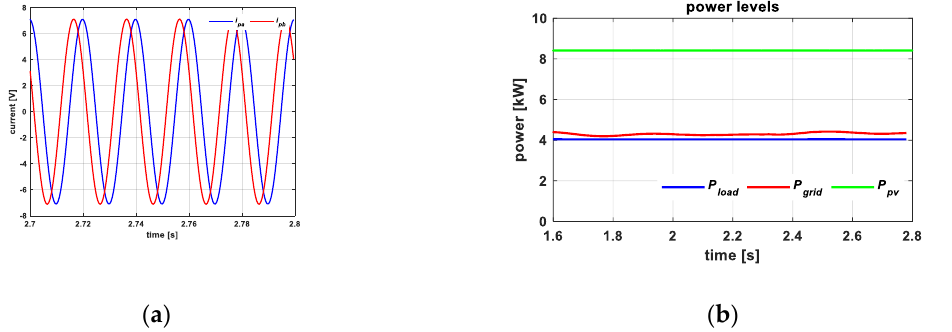
Figure 9. Steady-state behavior of load currents ( a ) and of power ( b ): load power (blue line), PV power (green line), and grid power (red line).